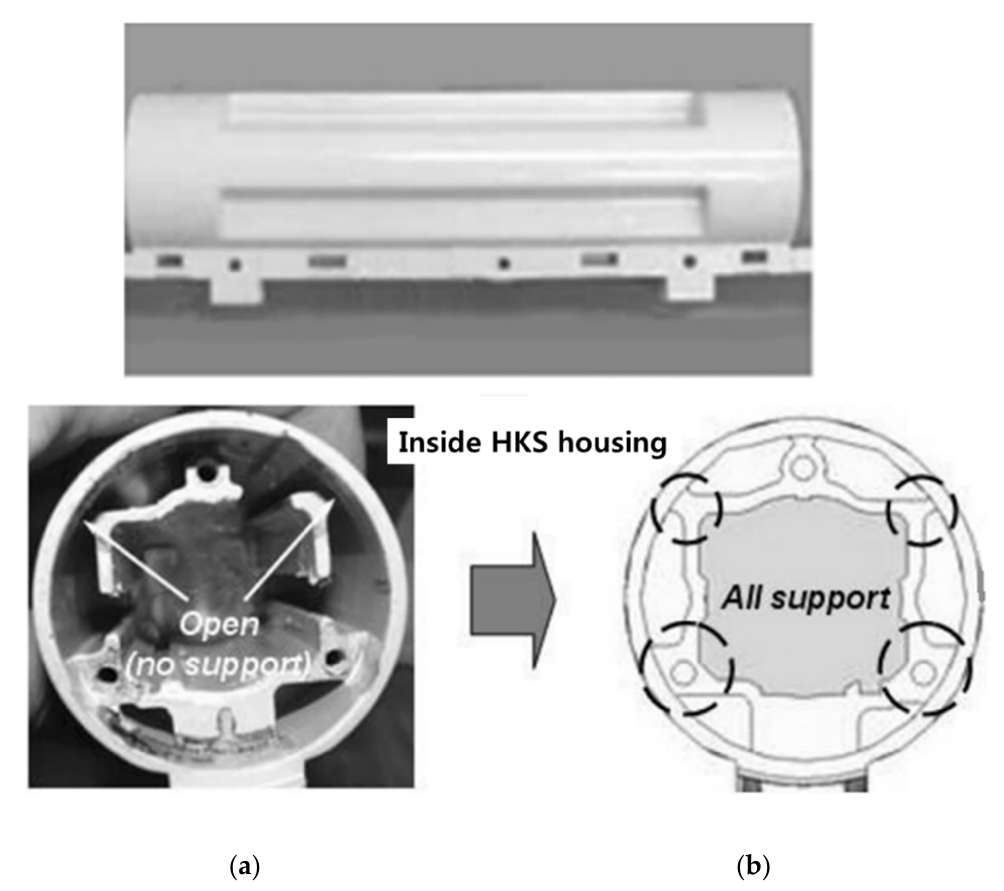
Figure 11. Failed HKS housing in the first ALT: ( a ) Its root cause; ( b ) design modifications. With the confirmed shape parameter β of 2.0, the real mission cycles computed from Equation (20) were 23,000 cycles for the six sample units. If the HKS failed at less than once for 23,000 cycles, its lifetime would be assured to be B1 life 10 years. As seen in Figure 12, in the second ALT, from the outside corner, the torsional shaft in the HKS that was made of ductile iron failed at 12,000 cycles. Such ductile cast iron accounts for a major family of metals that are extensively used for gears, automobile crankshafts, dies, and numerous machine parts because of its good machinability, fatigue strength, and high modulus of elasticity. They have a mass fraction (%) as follows: Carbon (3.0–3.7), silicon (1.2–2.3), manganese (0.25), magnesium (0.07), phosphorus (0.03)